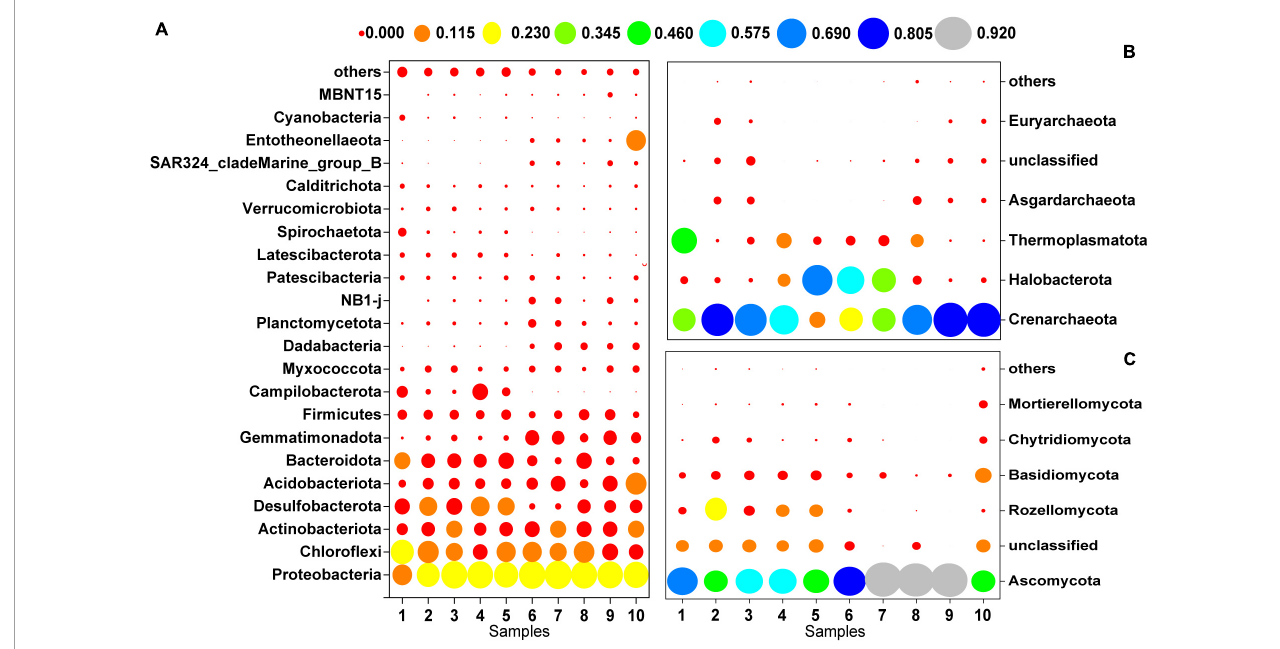
FIGURE3 Microbial community composition at the phylum level ( > 0.1%); (A) bacteria, (B) archaea, (C)